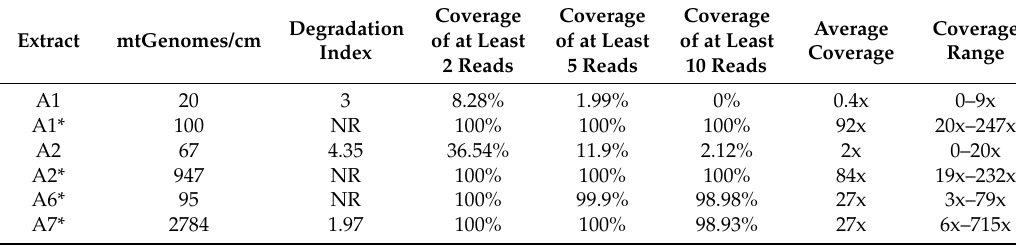
Table 7. mtDNA quantitation values, degradation indexes, and coverage over the mtGenome for aged hairs. The asterisk denotes DNA extraction using protocol B. NR: no